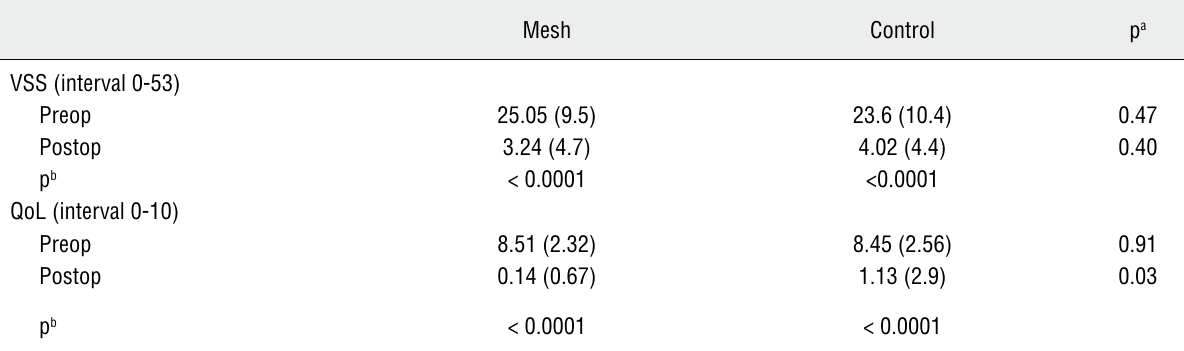
Table 4 - VSS and qoL scores (ICIq-VS) at the pre- and postoperatory periods from Mesh and Control groups. Values presented as mean ± standard deviation (SD).